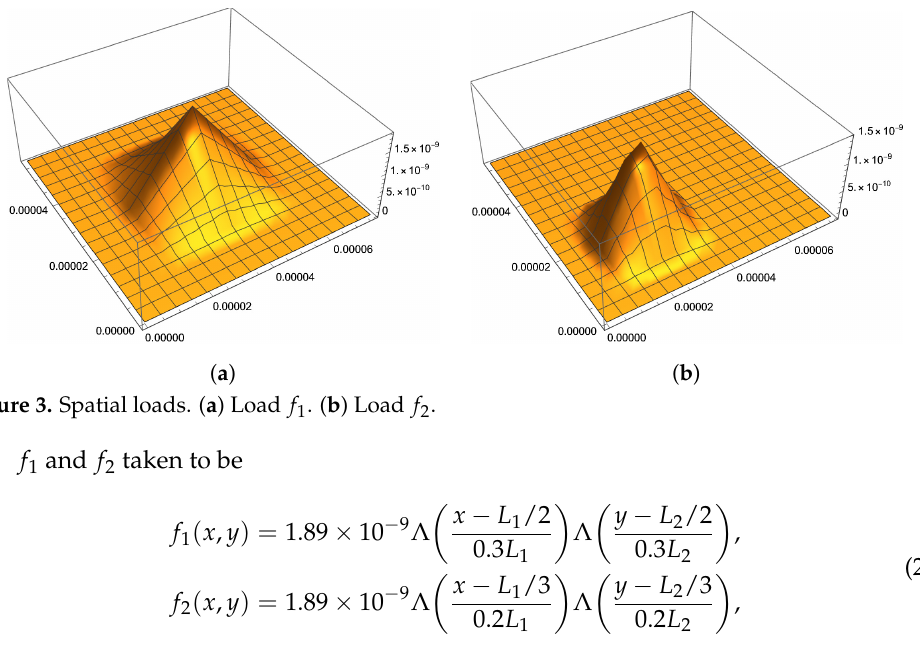
Figure 3. Spatial loads. ( a ) Load f 1 . ( b ) Load f 2 .